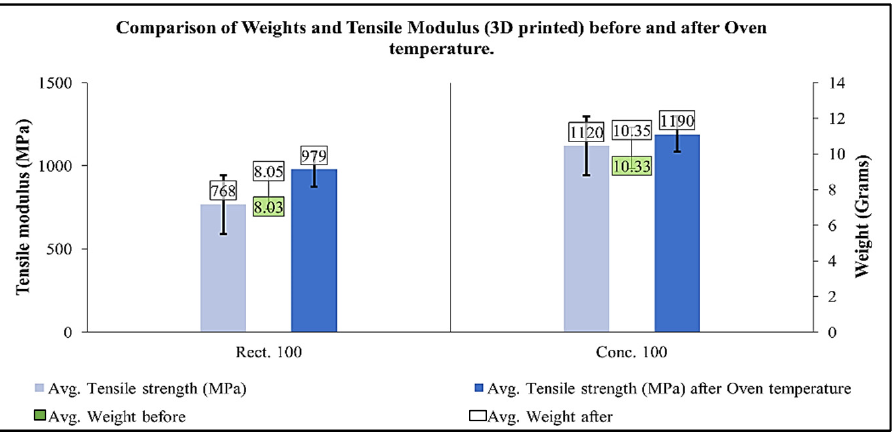
Figure 13. Comparison between weight and tensile modulus of PLA 3D-printed samples before and after oven temperature treatment.